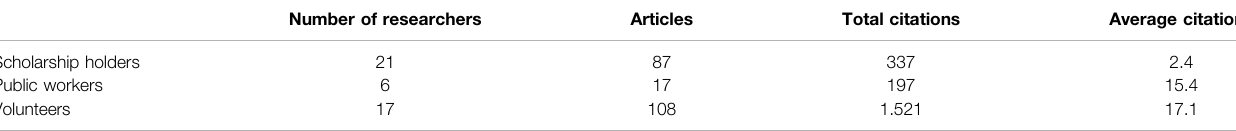
TABLE 3 | Distribution of INMA af fi liated articles according to the types of institutional links of their research collaborators (1993 – 2019).